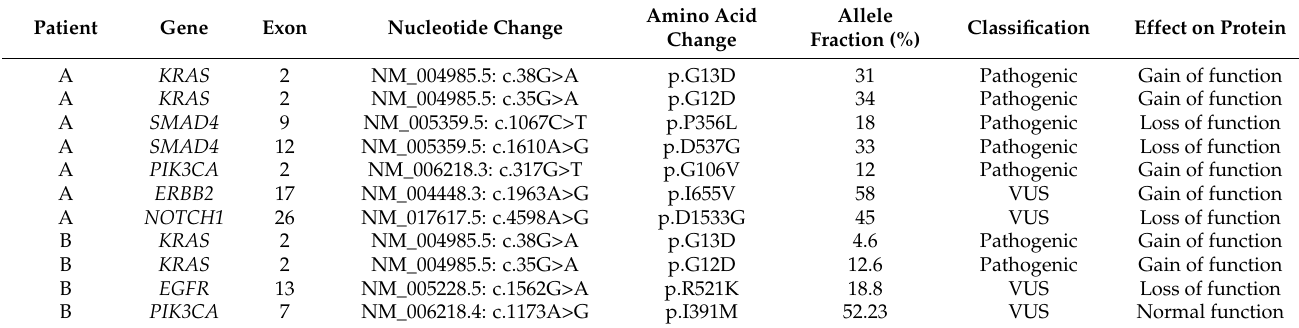
Table 1. Molecular variant details of patients analyzed by next generation sequencing